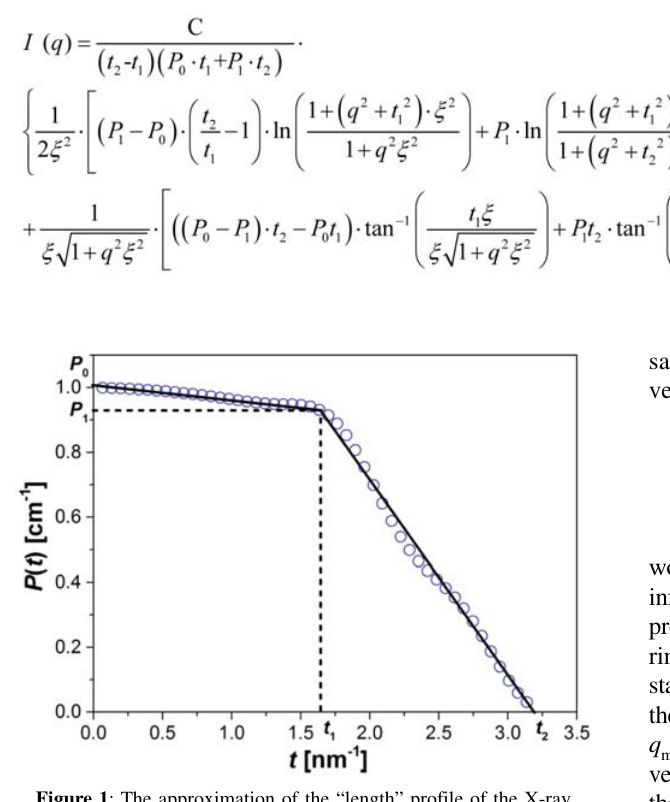
Figure 1 : The approximation of the “length” profile of the X-ray primary beam with two